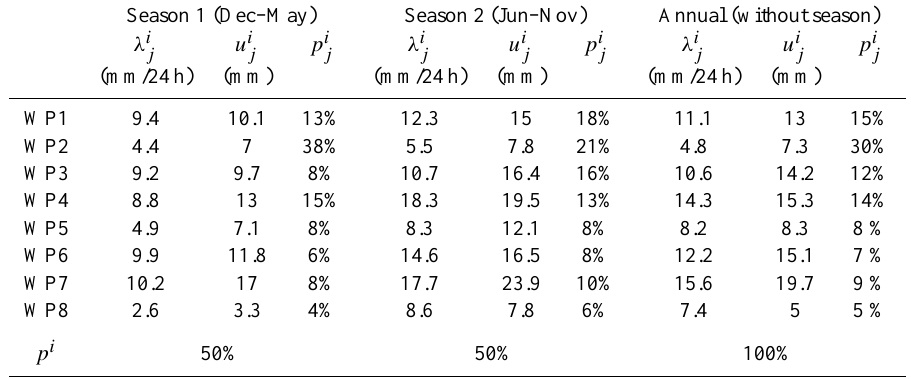
Table 3. Scale parameter λ i , threshold u i , weight p i for each weather pattern of the two seasonal MEWP distributions (season 1 from j j j December to May and season 2 from June to November) for Lyon. Last columns detail the annual MEWP distribution (without seasonal sub-sampling). The weights p i refer to the weights used to compute the global MEWP distribution, if season sampling is